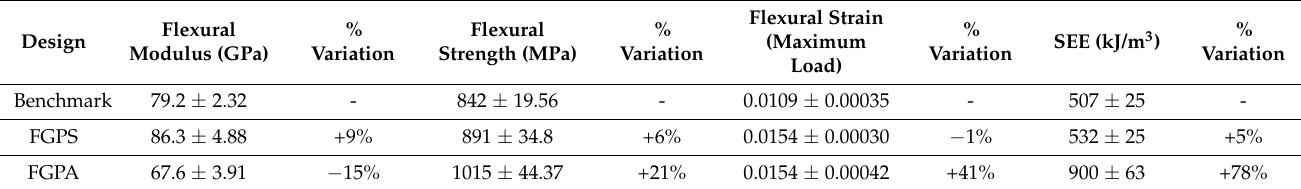
Table 2. Mean and standard deviation for the flexural data of the benchmark, symmetric (FGPS) and asymmetric (FGPA)